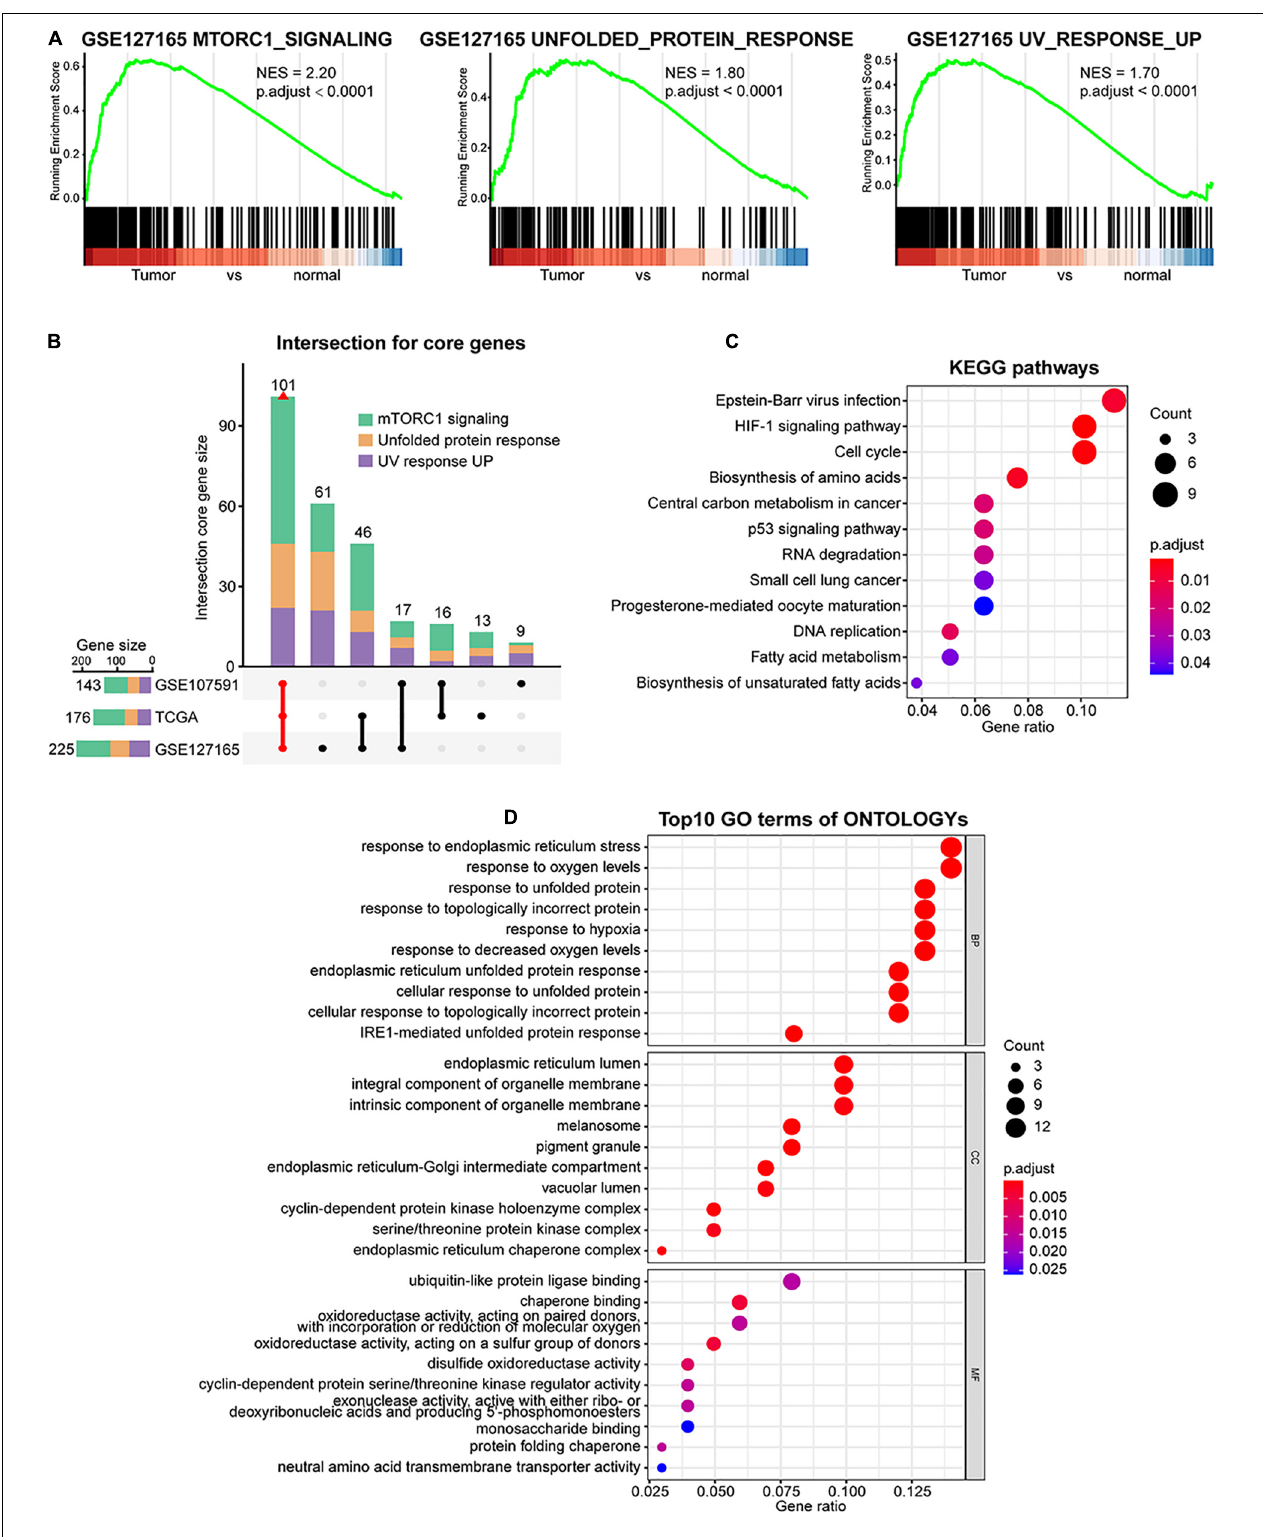
FIGURE 2 | Identification of the core genes in mTORC1 signaling, unfolded protein response (UPR), and UV response UP gene sets. (A) Gene set enrichment analysis (GSEA) shows that mTORC1 signaling, UPR, and UV response UP are significantly enriched in GSE127165 cohort. (B) Intersection of core genes based on GSEA from three databases is indicated in red. Kyoto Encyclopedia of Genes and Genomes (KEGG) (C) and Gene Ontology (GO) (D) analysis of the common core genes. BP, biological processes; CC, cellular components; MF, molecular function.